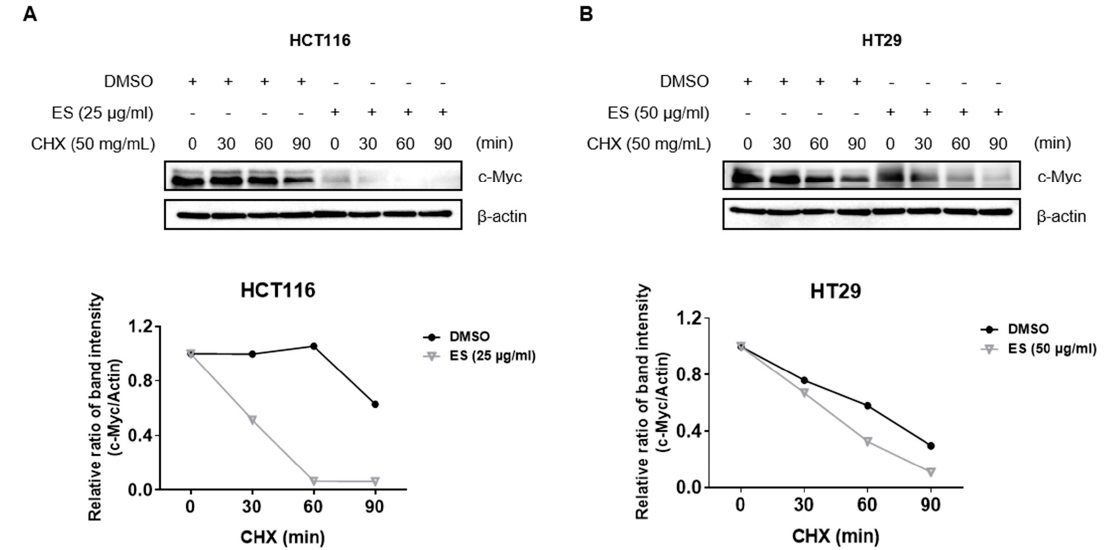
Figure 5. Effect of ES c-Myc stability in colon cancer cells. ( A ) HCT116 cells were treated with ES (25 µ g/mL) for 24 h. Then, the cells were exposed to 50 µ g/mL CHX at different time points (0, 30, 60, and 90 min). ( B ) HT29 cells were treated with ES (25 µ g/mL) for 24 h. Then, the cells were exposed to 50 µg/mL CHX at di ff erent time points (0, 30, 60, and 90 min).